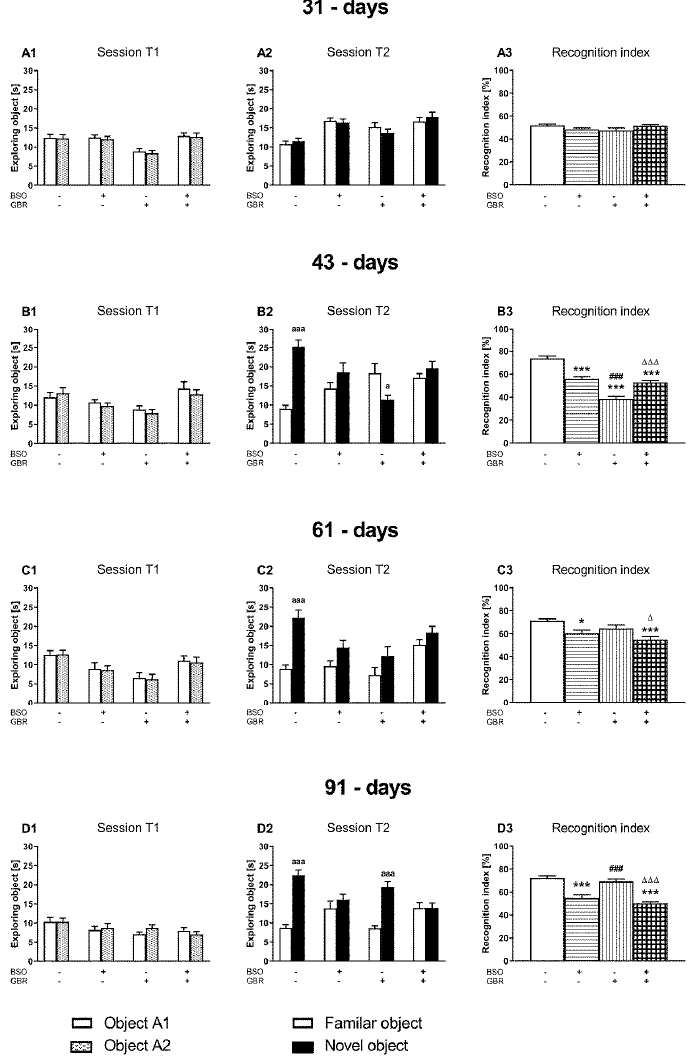
Figure 2. The effect of chronic administration of BSO and GBR 12909, alone or in combination, during postnatal days p5–p16 on cognitive functions assessed in adolescent ( A – C ) and adult ( D ) Sprague– Dawley rats. ( A1 – D1 ) The effects of the studied model compounds on the exploration of two identical objects in the acquisition trials (session T1). ( A2 – D2 ) The effects of the studied model compounds on the exploration of a novel and familiar object in the retention trial (Session T2). ( A3 – D3 ) The effects of the studied model compounds on the recognition index. Data are presented as the mean ± SEM, n = 10 for each group. Letters indicate statistically significant differences between the exploration time of a novel and familiar object in the session T2 within each studied group, according to the Student’s t -test for independent samples, aaa p < 0.001, a p < 0.05 vs. familiar object. Statistical analysis of the recognition index was performed using a two-way ANOVA; symbols indicate significance of differences according to the Newman–Keuls post hoc test, *** p < 0.001, * p < 0.05 vs. control; ### p < 0.001 vs. BSO- and ∆∆∆ p < 0.001, ∆ p < 0.05 vs. GBR 12909-treated